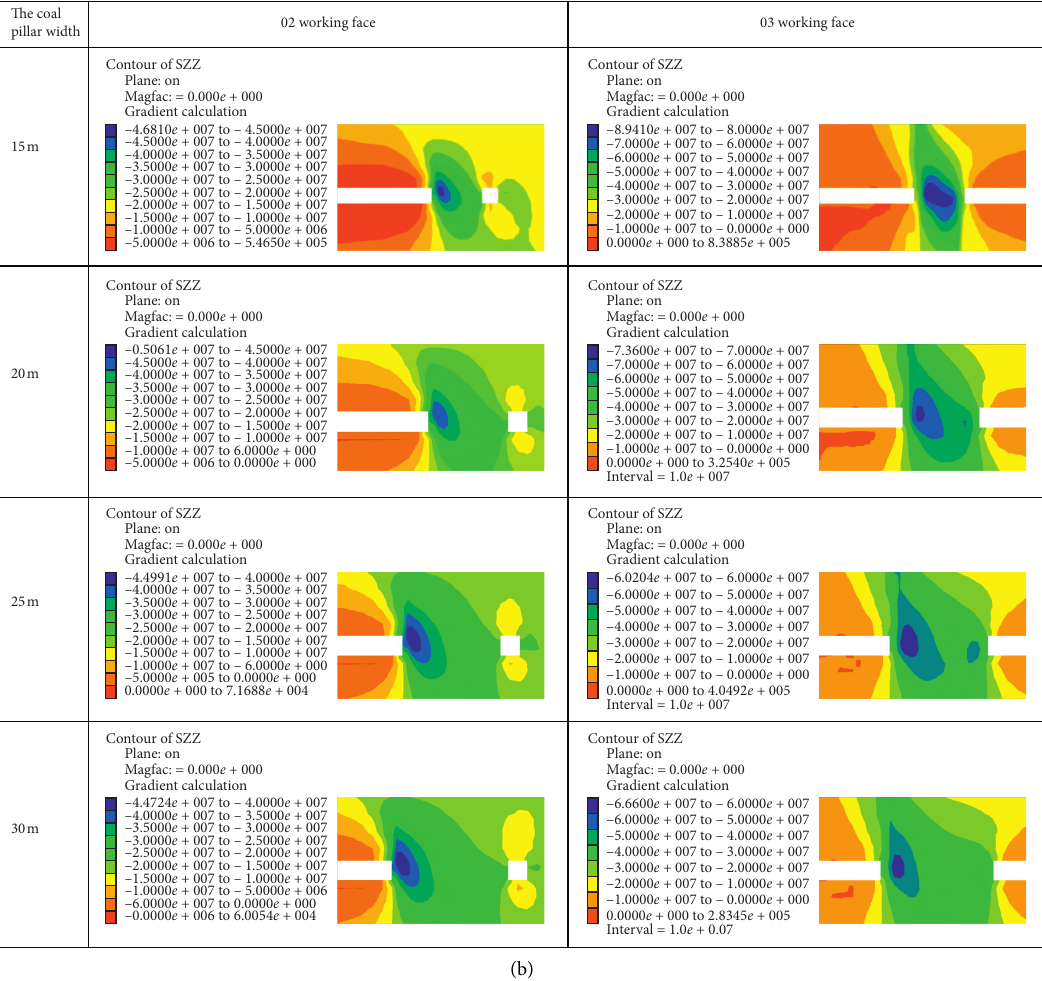
Figure 12: Vertical stress distribution diagram of coal pillars with different widths of 02# and 03# working faces during